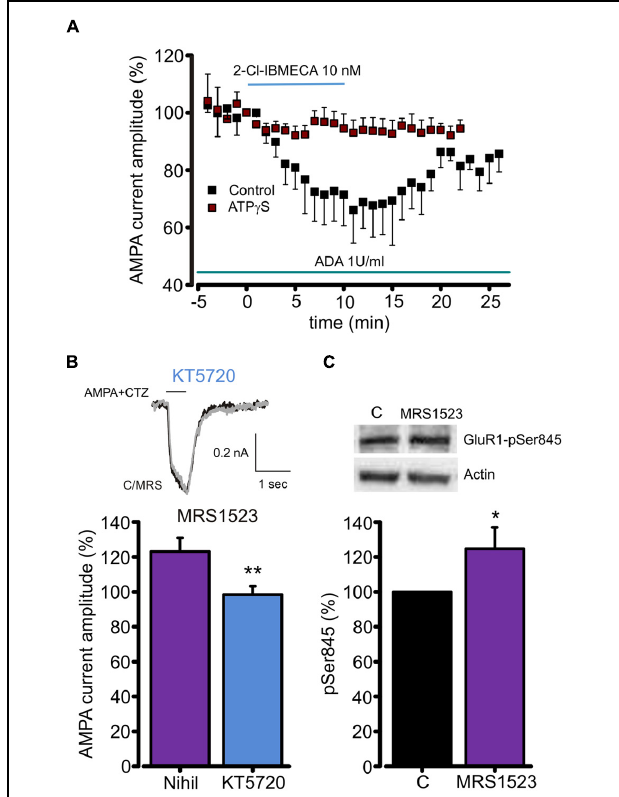
FIGURE 4 | A 3 R dependent AMPARs modulation requires GluR1 dephosphorylation. (A) Time course of the effect of the A 3 R agonist 2-Cl-IBMECA on AMPA current amplitude in the continuous presence of ADA (1 U/ml, 1 h preincubation) in control condition (black, n = 12) and after substitution of intracellular ATP with the thiophosphorylating agent ATP γ S ( n = 6). (B) Bar chart and sample traces displaying mean AMPA current potentiation induced by A 3 R antagonist MRS1523 in control and in the presence of PKA blocker KT5720 ( n = 6). (C) Representative immunoblot and quantitative western blot analysis of the effect of MRS1523 on the level of basal Glur1 Ser845 phosphorylation ( n = 13). ∗ p < 0.05, ∗∗ p <